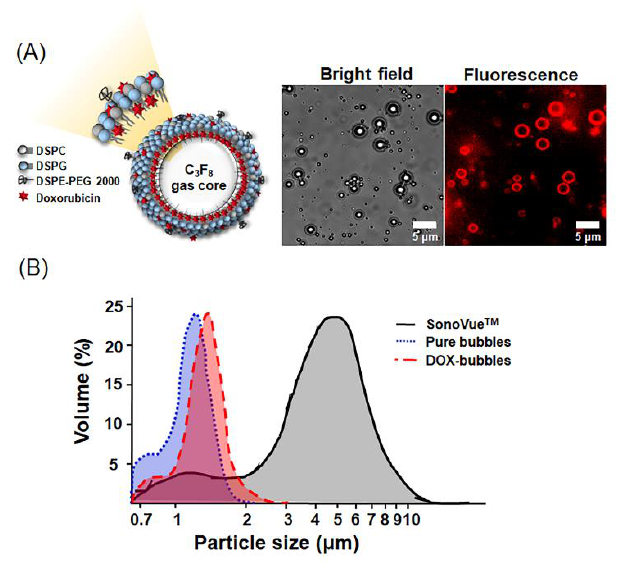
Figure 3. Size distribution and morphology of DOX (doxorubicin)-bubbles. ( A ) Left: the of DOX-bubbles; right: the bright field and fluorescent images of DOX-bubbles. Both of the images show the sphere shape of the DOX-bubbles, and the fluorescent image indicates the DOX molecules were incorporated in the lipid membranes. ( B ) Size distribution of pure bubbles, SonoVue TM , and DOX-bubbles.